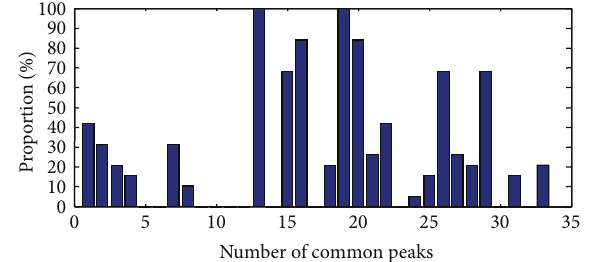
Figure 6: The frequency proportion of the number of significantly different common peaks to 19 batches of